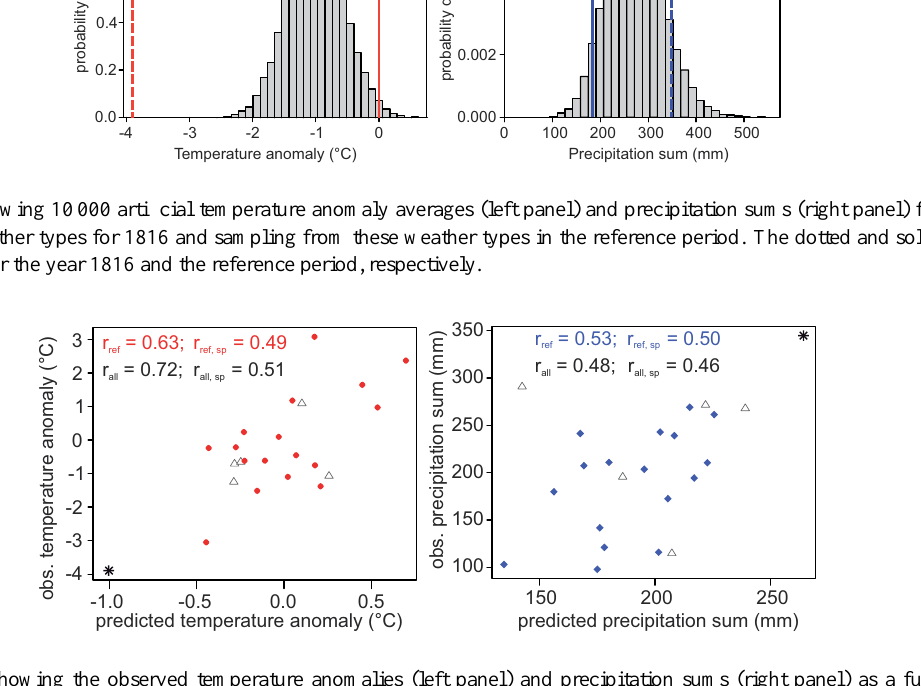
Fig. 9. Scatter plot showing the observed temperature anomalies (left panel) and precipitation sums (right panel) as a function of their predicted values based only on the weather types information. The years in the reference period are indicated in red and blue (points), for temperature and precipitation, respectively, the years that were excluded from the reference period are shown in grey (triangles), 1816 in black (stars). Correlation ( r ) and non parametric Spearman correlation ( r sp ) coefficients are shown for only the reference period (subscript ref, red number) and all years (subscript all, black